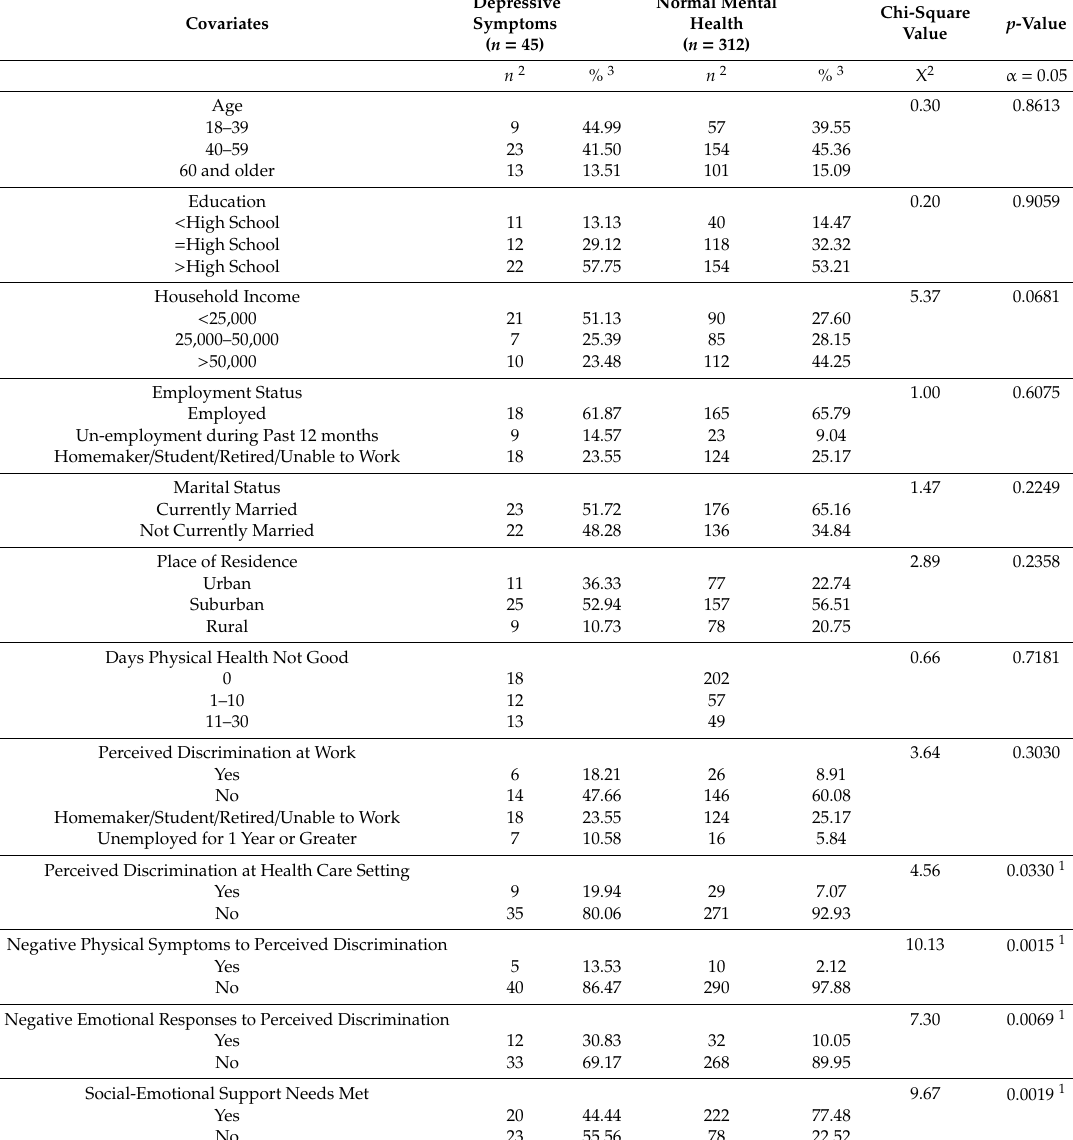
Table 1. Weighted Chi-square analysis of the characteristics of African American (AA) men in the southeastern United States by mental health status, Behavioral Risk Factor Surveillance System (BRFSS)